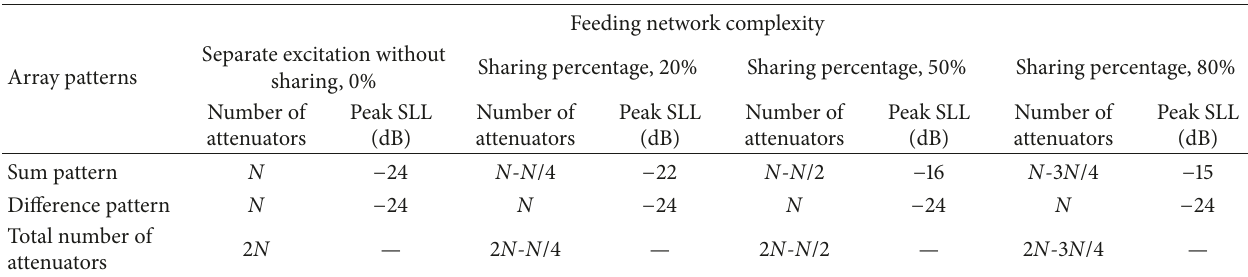
Figure 6: Sum and difference patterns (a) and the corresponding amplitude excitation (b) for the case of fixed sum pattern, 50% common excitation, and 𝑁 = 100 elements. Table 2: Complexity of the feeding network for different